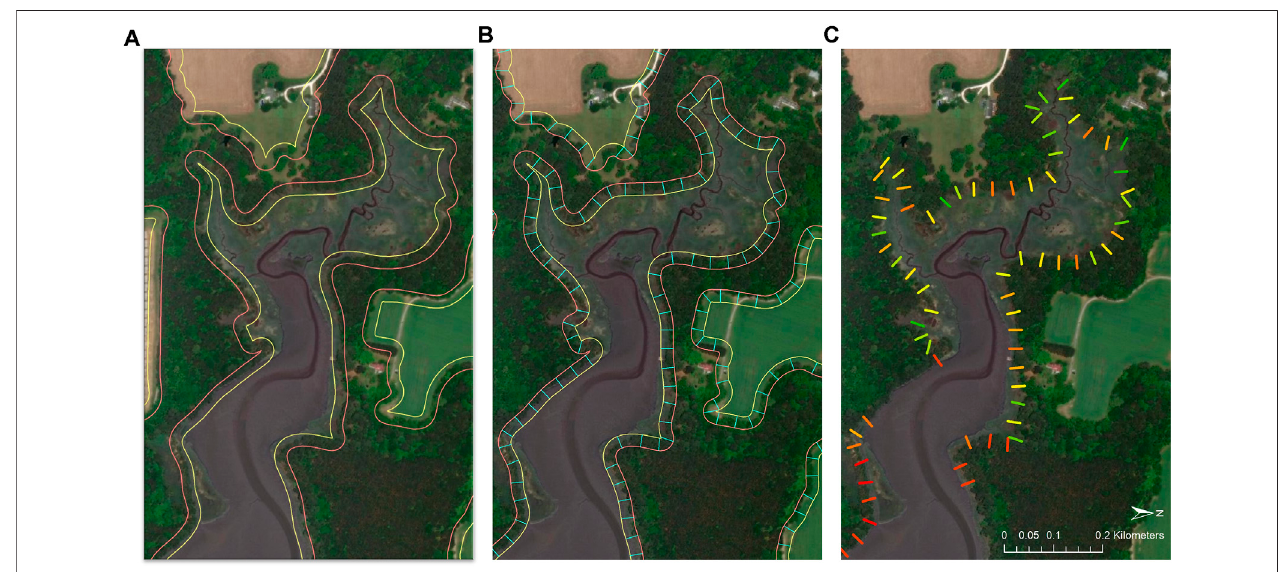
FIGURE 2 | Location of marsh-forest boundary is the same as the inset in Figure 1 . (A) Shoreline (yellow) and baseline (pink) input fi les for DSAS set 20 m apart, between which (B) transects, blue, are cast with a 30 m spacing (C) Removed extraneous transects cast between forest and non-marsh land types and assigned remaining transects a slope value from TBDEM (indicated by color gradient of green, low slope, to red, high slope).